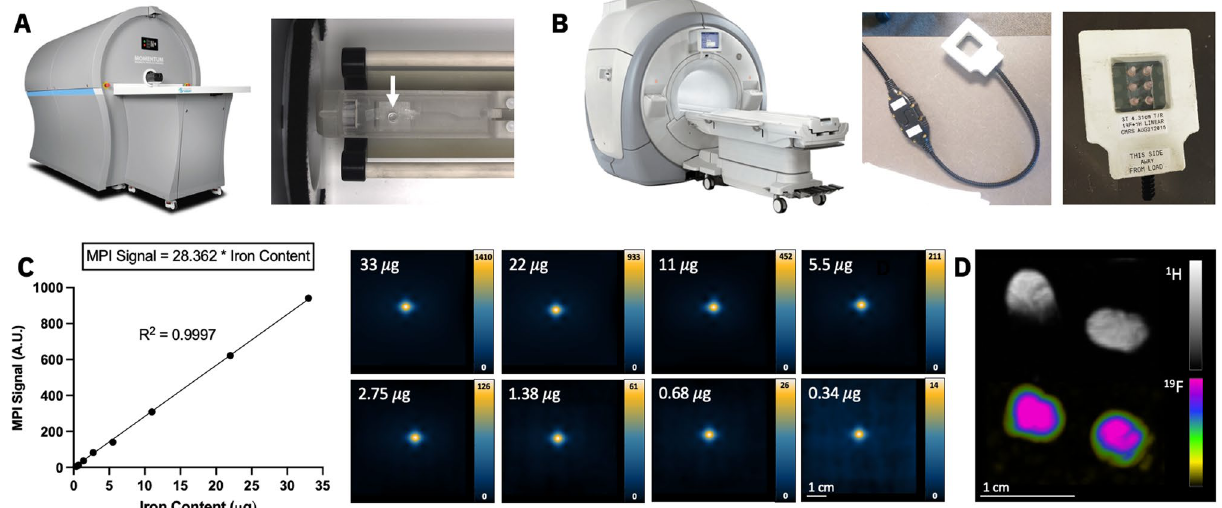
Figure 1. ( A ) Image of a preclinical Momentum MPI and sample holder (white arrow), where individual ferucarbotran-labeled cell samples were placed for imaging. ( B ) Photos of a clinical 3 Tesla MRI with the dual- tuned ( 1 H/ 19 F) surface coil, used for 19 F imaging of 6 cell samples. ( C ) A strong linear relationship exists between MPI signal and iron mass (R 2 = 0.9997). This was determined by imaging multiple samples of ferucarbotran (0.34–33 μg) and measuring the MPI signal from each sample. The linear equation is subsequently used to convert a measure of MPI signal from ferucarbotran-labeled cells to a measure iron content (μg). ( D ) 1 H and 19 F images of two reference phantoms, containing known amount of 19 F content (3.33 × 10 16 19 F spins/μL), are used for quantification of 19 F in cell